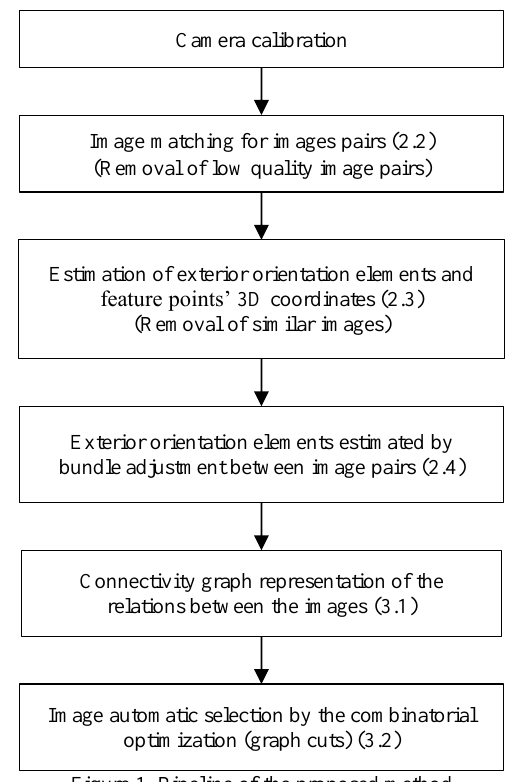
Figure 1. Pipeline of the proposed method